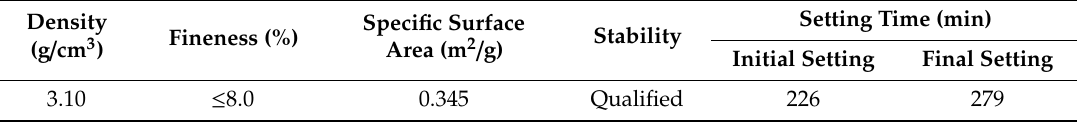
Table 6. The physical properties of Portland cement.